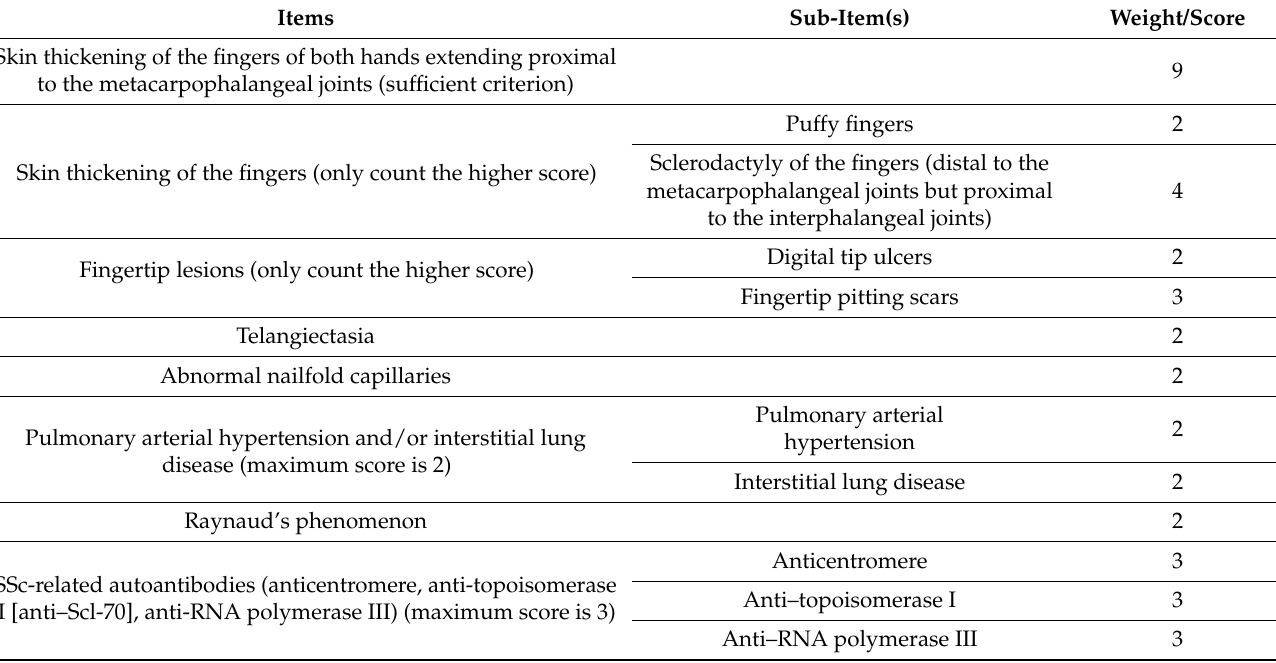
Table 2. ACR/EULAR 2013 Systemic Scleroderma classification criteria. Adapted from Van Den Hoogen et al.